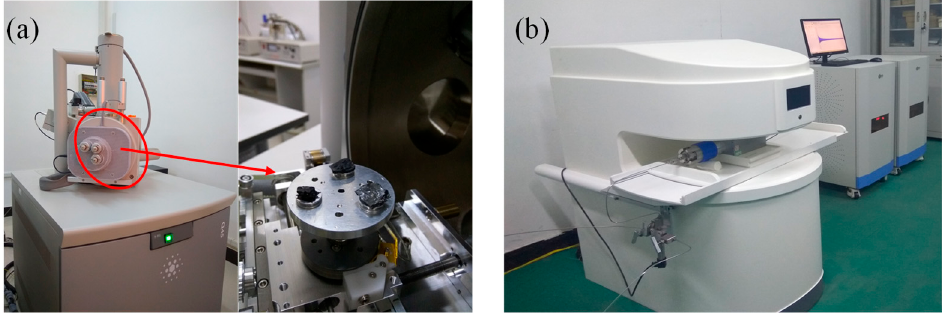
Figure 3. Apparatus of ( a ) SEM and ( b ) NMR tests .